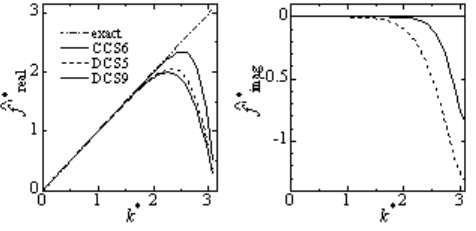
Fig. 2 Modified wavenumbers for the first derivative approximations of